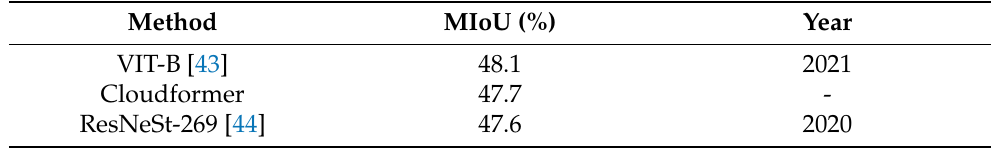
Table 6. Comparison of different semantic segmentation methods on